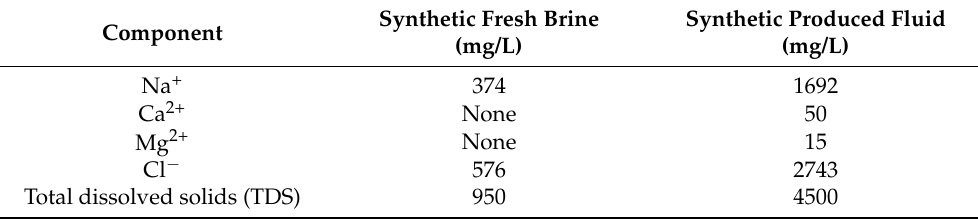
Table 4. The composition and salinity of the synthetic fresh brine and produced fluid.